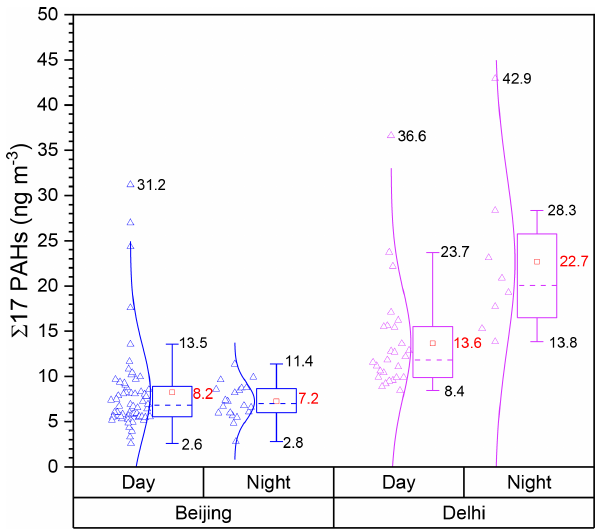
Figure 3. Concentrations of 17 PAHs in PM 2 . 5 samples during the daytime (3h) and night-time (15h). Box plots represents the 25th and 75th percentile range of the observed concentrations, and the whisker numbers reflect the data within 1.5 times the interquartile range (IQR). Red square symbols represent the mean concentra- tion, and the short dashed line within the boxes represents the me- dian. Empty triangles correspond to the data measured over 3h and 15h in Beijing (Blue) and in Delhi (Purple). The lines between data points and boxes reflect a normal distribution curve.